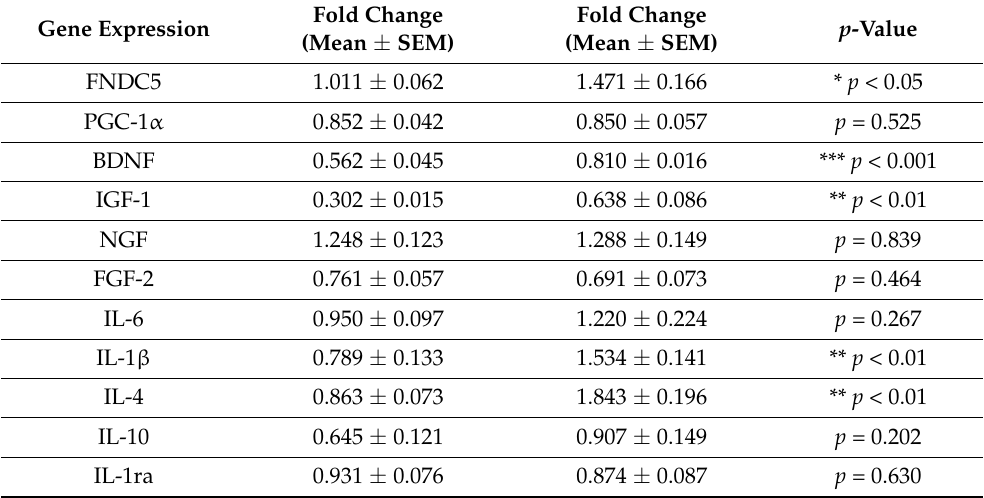
Table 2. Summary of qRT-PCR results in